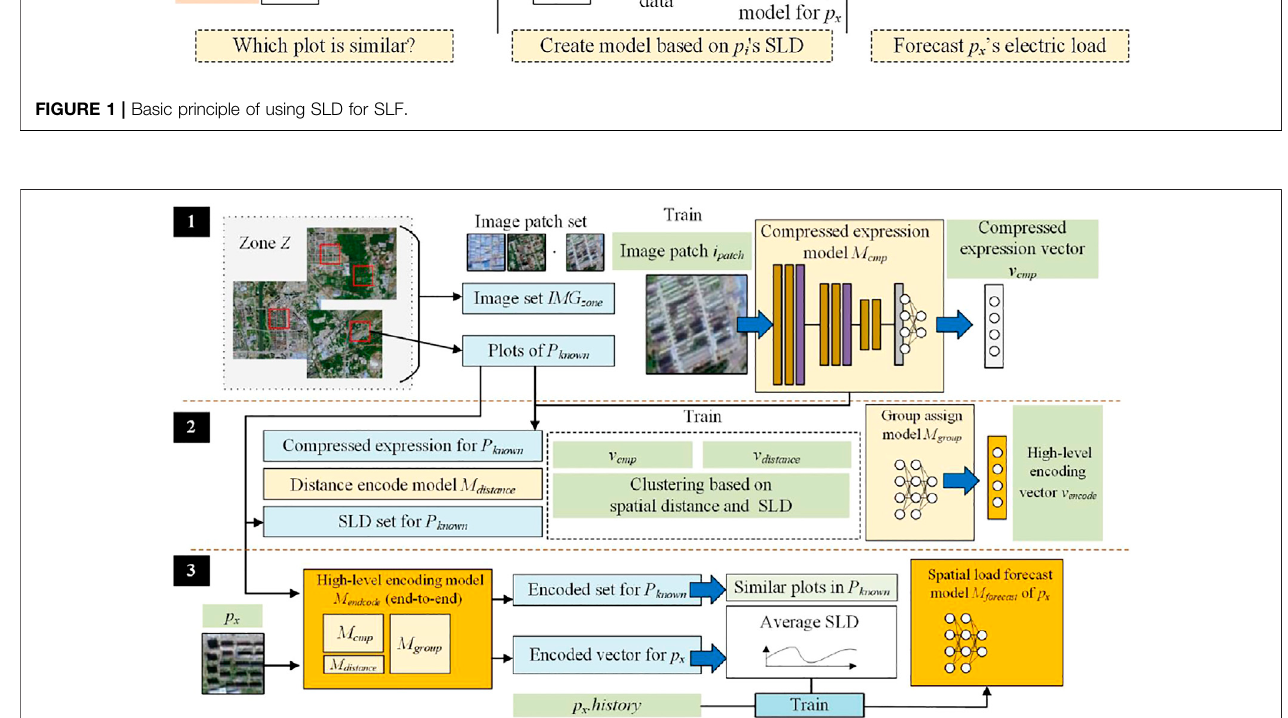
FIGURE 2 | Overall process of